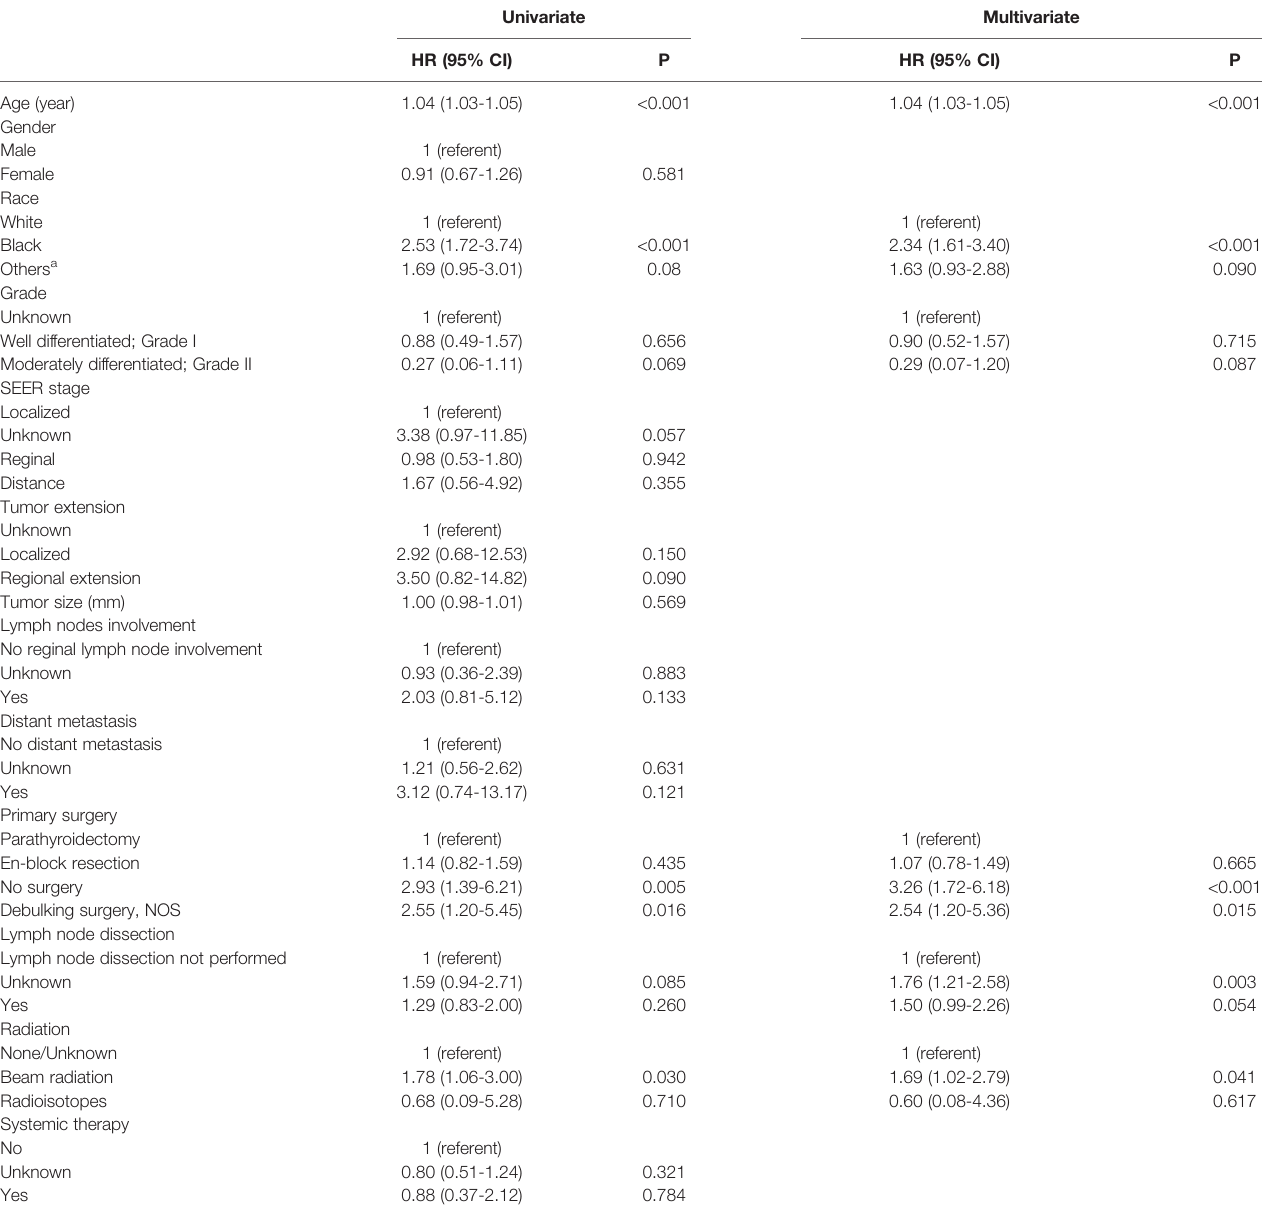
TABLE 2 | Univariate and multivariate cox proportional hazards regression model highlighting overall survival in the parathyroid carcinoma patient